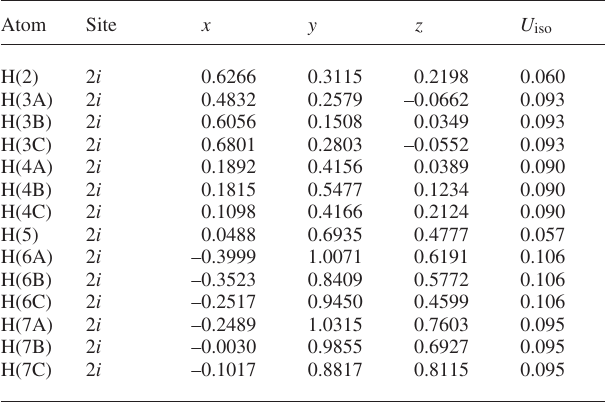
Table 2. Atomic coordinates and displacement parameters (in Å 2 )